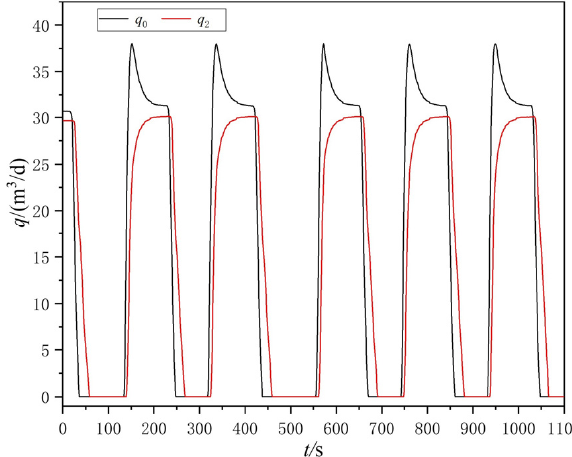
Figure 10. Transient discharge variation curves at upstream and downstream monitoring points.